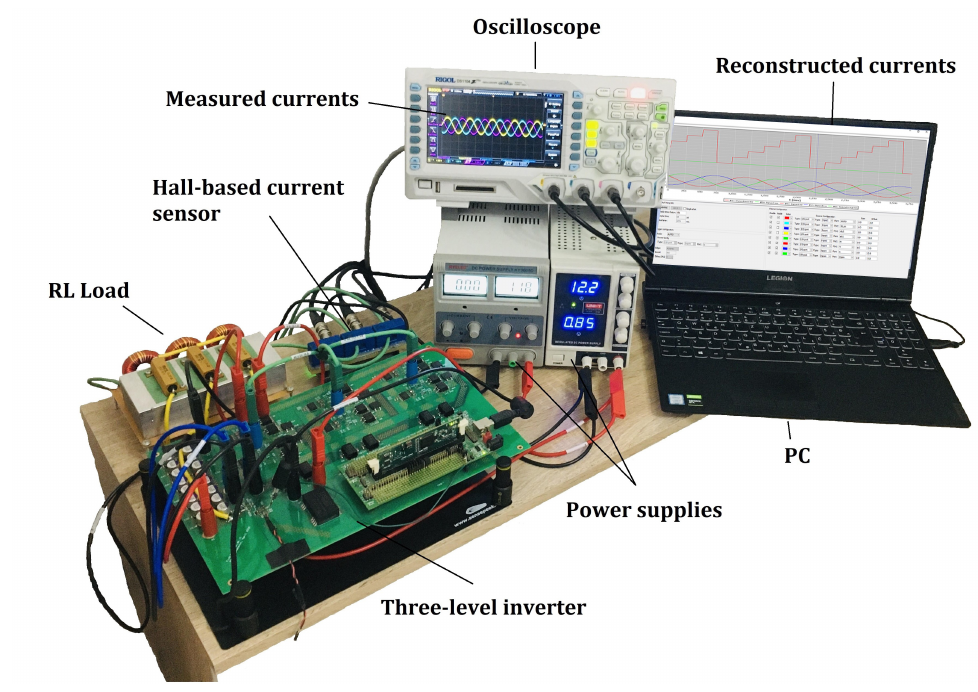
Figure 9. Measurement